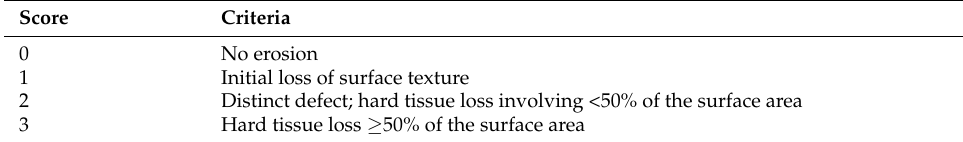
Table 1. BEWE (basic erosive wear examination) scores and